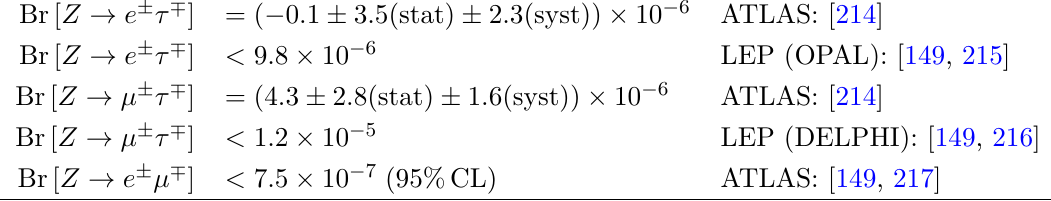
Table 2. Experimental bounds on Z → ‘‘ 0